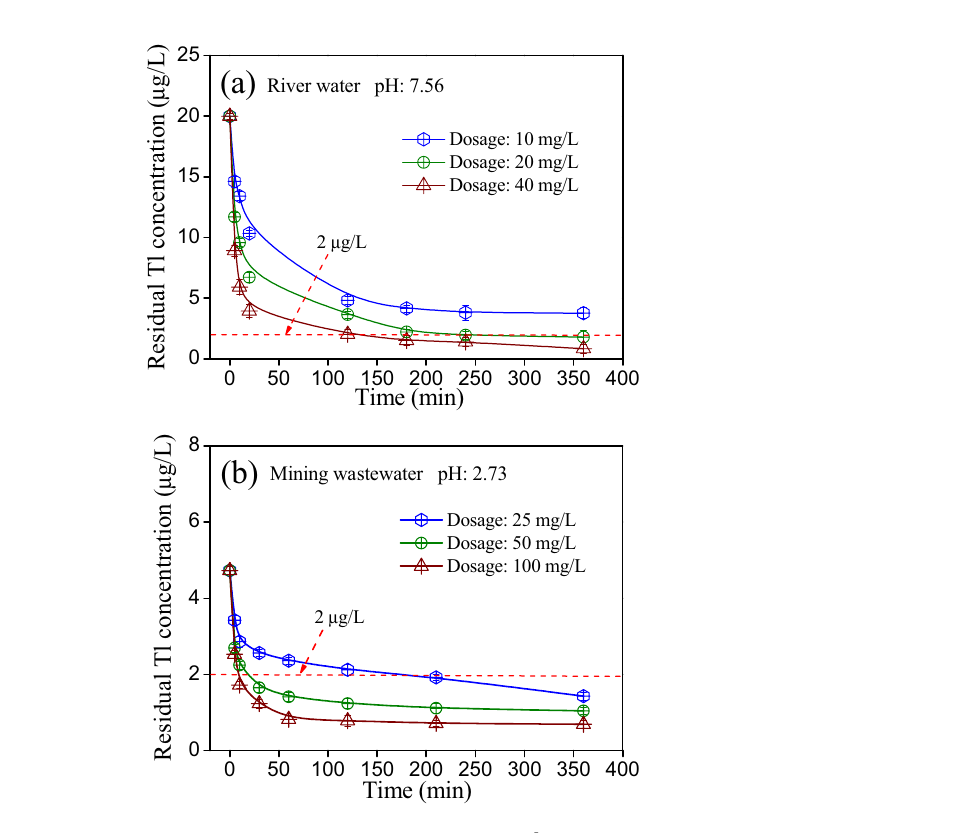
Figure 8. Kinetics of Tl(I) removal by TiO 2 I from the ( a ) spiked Pearl River water and ( b ) mining